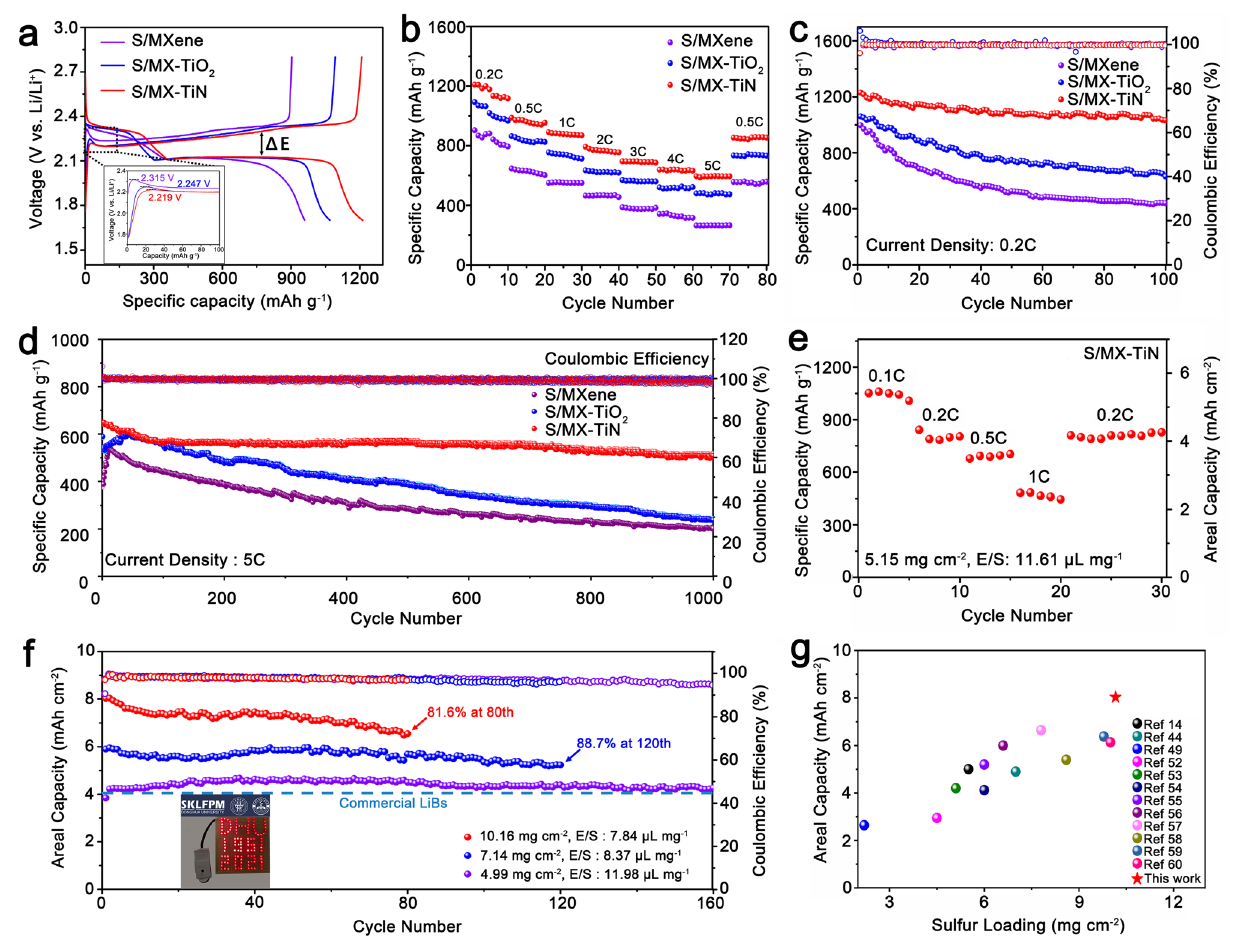
Fig. 6 a The initial discharge–charge profiles of S/MXene, S/MX‑TiO 2, and S/MX‑TiN cathodes. b Rate performance and c cycling performance at 0.2C of S/MXene, S/MX‑TiO 2, and S/MX‑TiN cathodes. d Long‑term cyclability of S/MX‑TiN, S/MX‑TiO 2 , and S/MXene at 5C. e Rate capa‑ bility of S/MX‑TiN at a high sulfur loading of 5.15 mg cm −2 and E/S ratio of 11.61. f Cycling performance of S/MX‑TiN cathode at different sulfur loading of 4.99, 7.14, and 10.16 mg cm −2 , respectively. Inset: Optical photograph of a “DHU 1951 2021” shape composed of 115 LED lamps. g Comparison of sulfur loading and areal capacity of S/MX‑TiN cathode with other reported MXene‑based and titanium‑based sulfur